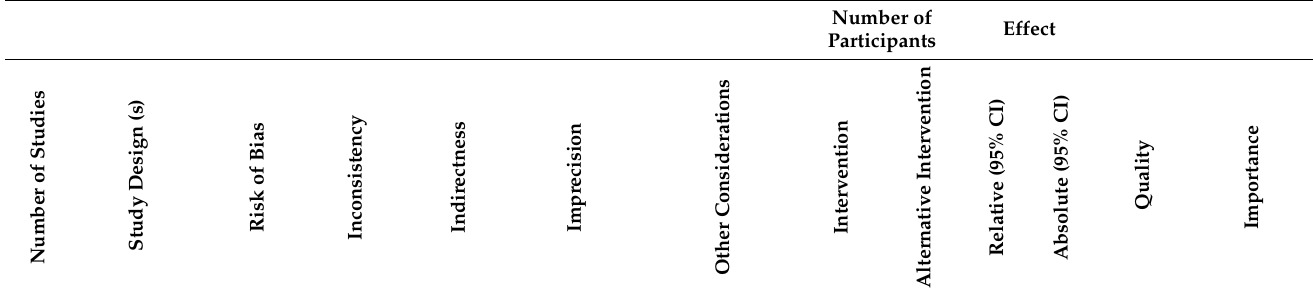
Table 5. The strength of evidence for the evaluated